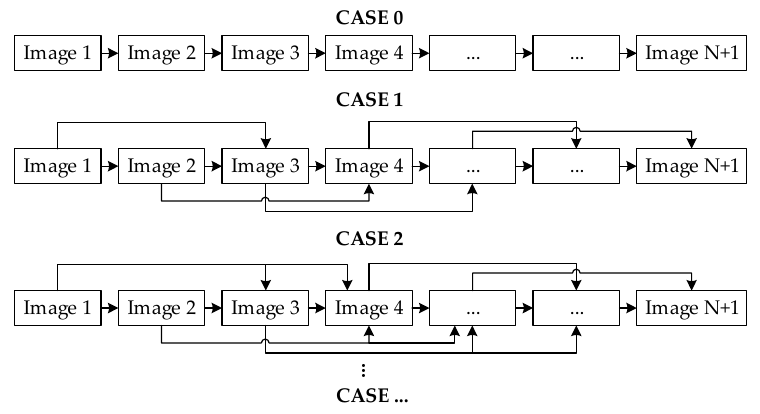
Figure 2. The interferogram networking categories for N + 1 SAR images. In the conventional SBAS-InSAR method, one of the images is selected as the primary image for the coregistration, and the interferometric pairs conforming to the spatiotemporal baseline threshold are selected from all the freely combined interferograms. The interferograms with a small baseline can be applied to the situation with rapid decorrelation in the time domain. However, the SBAS-InSAR method constrains the spatiotemporal baseline and rejects other high-quality interferograms. Consequently, there may be no redundant ob- servation for some isolated interferograms, and such category may induce the accumulated error propagation. To limit the propagation of errors, high-quality redundant observations can be added to network of interferograms. In such a case, there is no spatiotemporal baseline threshold constraint, and all the interferograms that are conforming to the ASC threshold can be participated in the interferogram